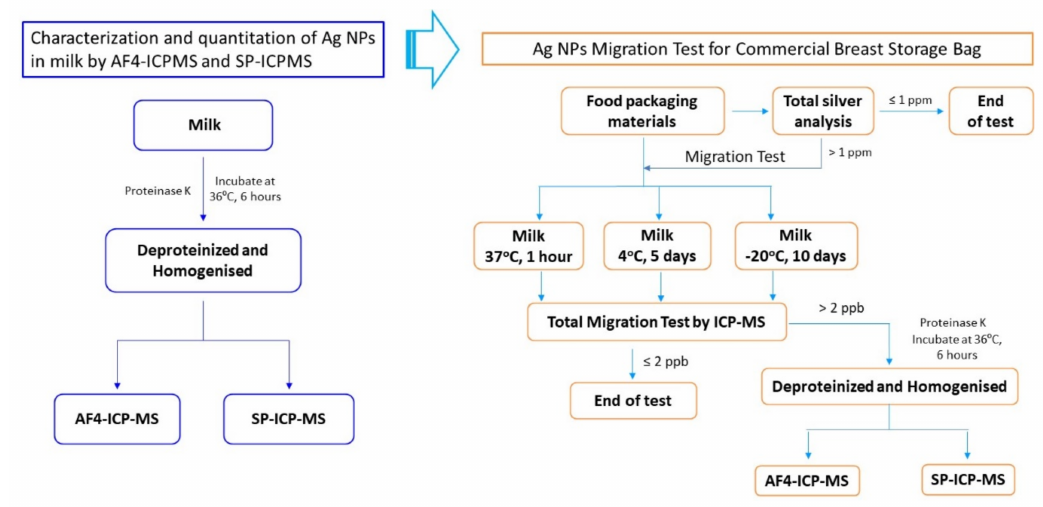
Figure 1. Experimental design for the characterization and quantitation of AgNPs in milk by AF4- ICP-MS and SP-ICP-MS, as well as the testing of AgNPs migrated from commercial breast milk storage bag into